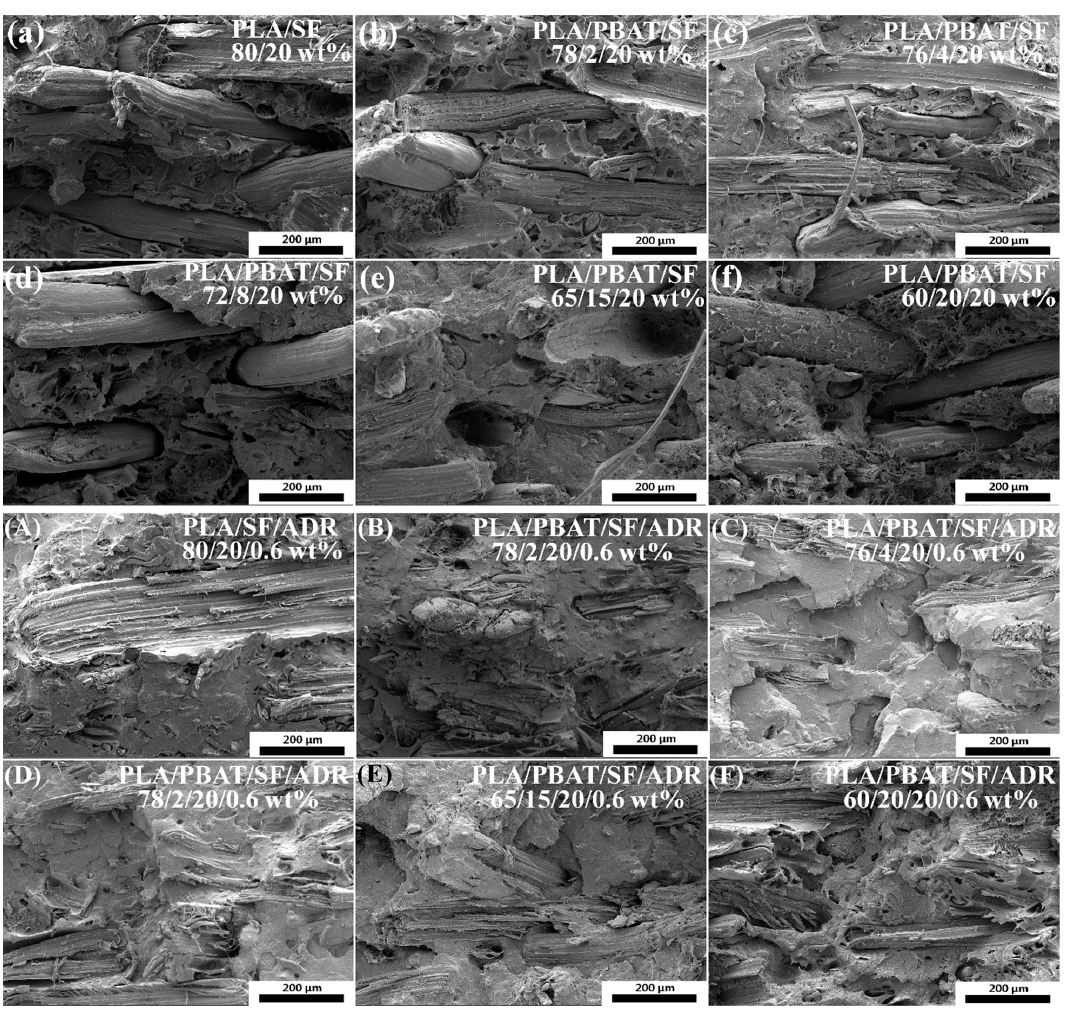
/ SF composites ( a ); PLA / PBAT / SF composites Figure 4. SEM micrographs of tensile fracture surfaces of PLA/SF composites ( a ); PLA/PBAT/SF Figure 4. SEM micrographs of tensile fracture surfaces of PLA Polymers 2019 , 11 , x FOR PEER REVIEW ( b – f ); PLA / SF / ADR composites ( A ); PLA / PBAT / SF / ADR composites ( B – F ). 500 × magnification.